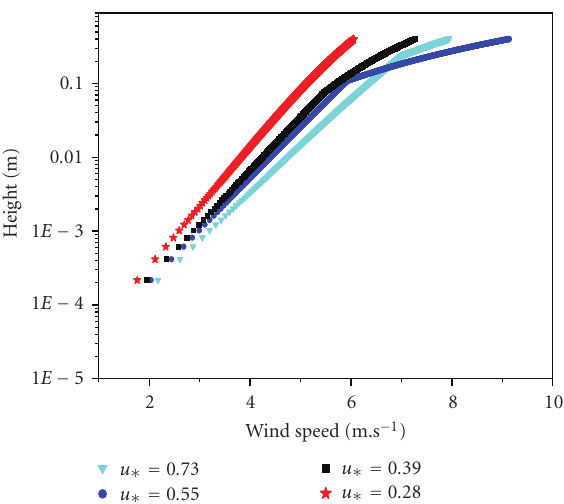
Figure 4: Calculated wind profiles with drifting fine snow.